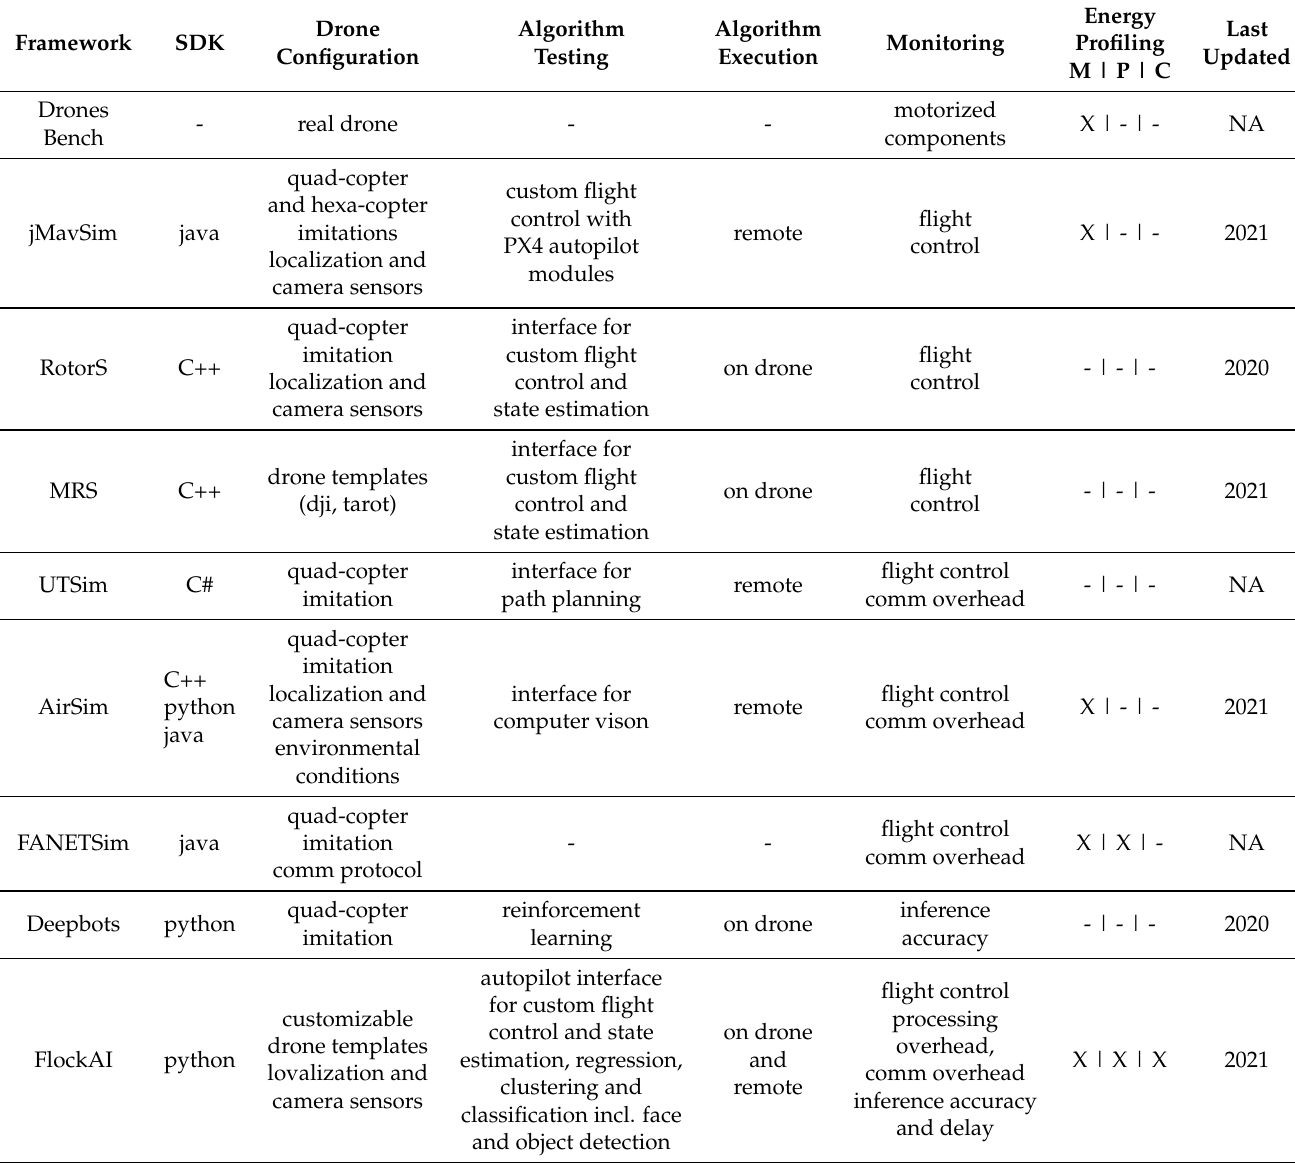
Table 5. Qualitative comparison of the SOTA in drone testing (M, P, and C in energy profiling denote the energy consumption attributed to the motorized, processing, and communication components,